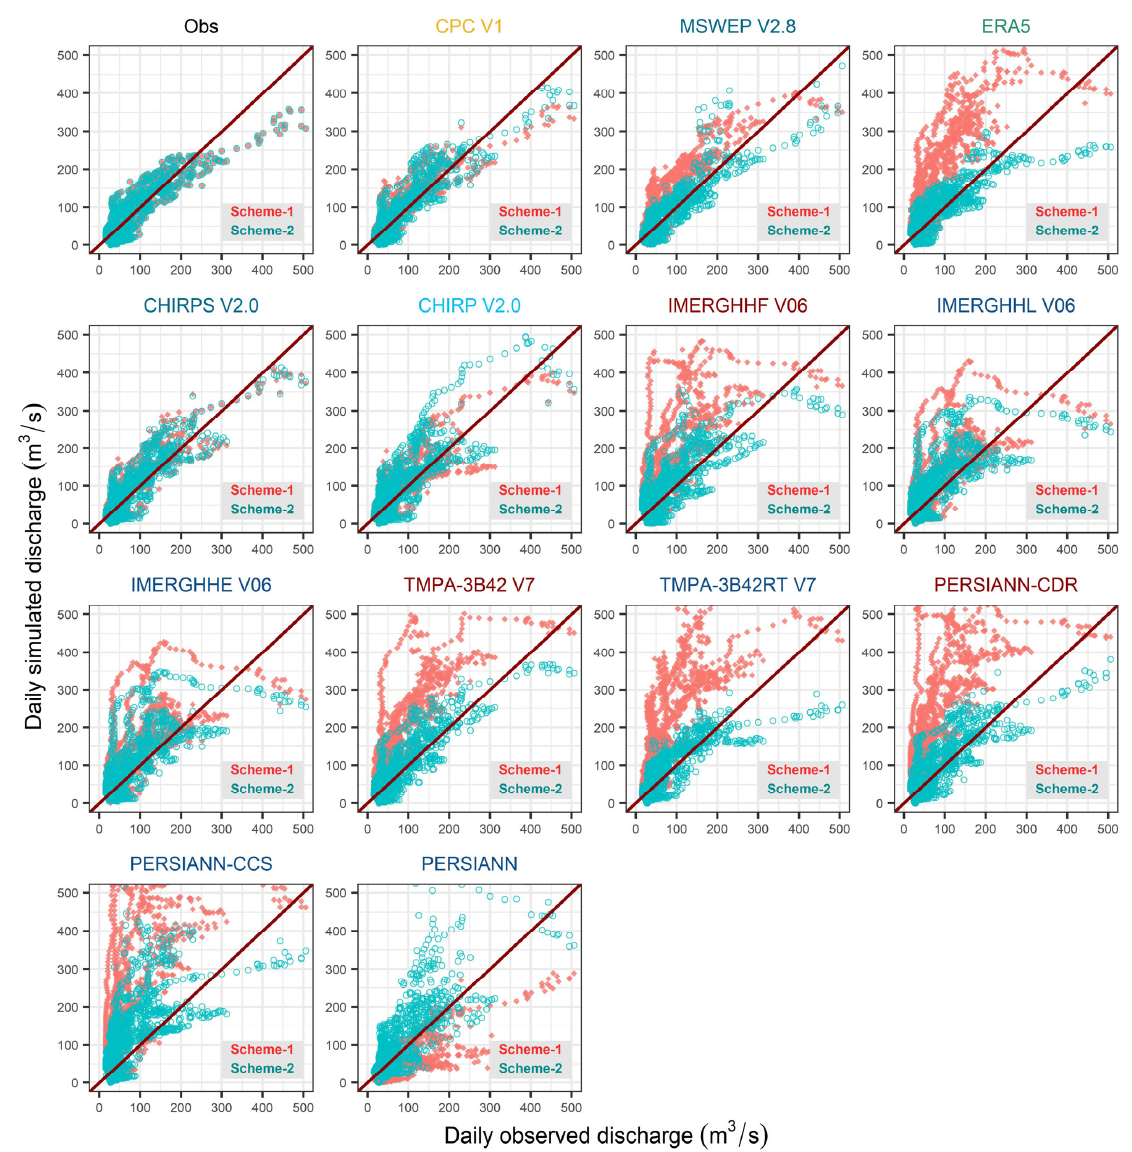
Figure 10. Scatter plot of daily simulated streamflow against observed discharge for the observed precipitation and 13 GPDs at Karasu basin outlet. Title color presents: observed (black), satellite-based (blue), gauge and satellite (red), reanalysis and satellite (sky blue), reanalysis (green), reanalysis, ground, and satellite (steel blue), and ground (yellow).